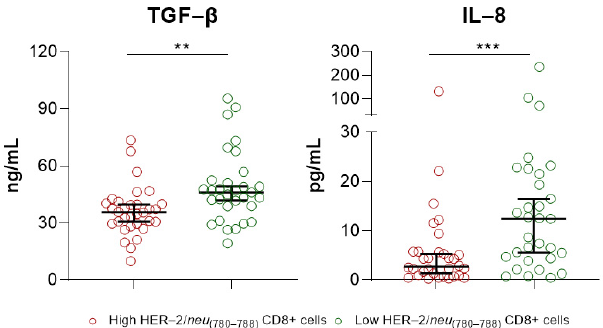
Figure 3. The majority of prostate cancer (PCa) patients with high frequencies of HER-2/ neu (780–788) - specific CD8+ T lymphocytes had lower levels of either interleukin-8 (IL-8) or transforming growth factor beta (TGF- β ). The graphs depict the association between the levels of IL-8 and TGF- β (high vs. low) in PCa patients with high or low HER-2/ neu (780–788) -specific CD8+ T lymphocyte frequencies. The results are presented as median values with 95% confidence intervals (CI). ** p < 0.01, *** p < 0.001.